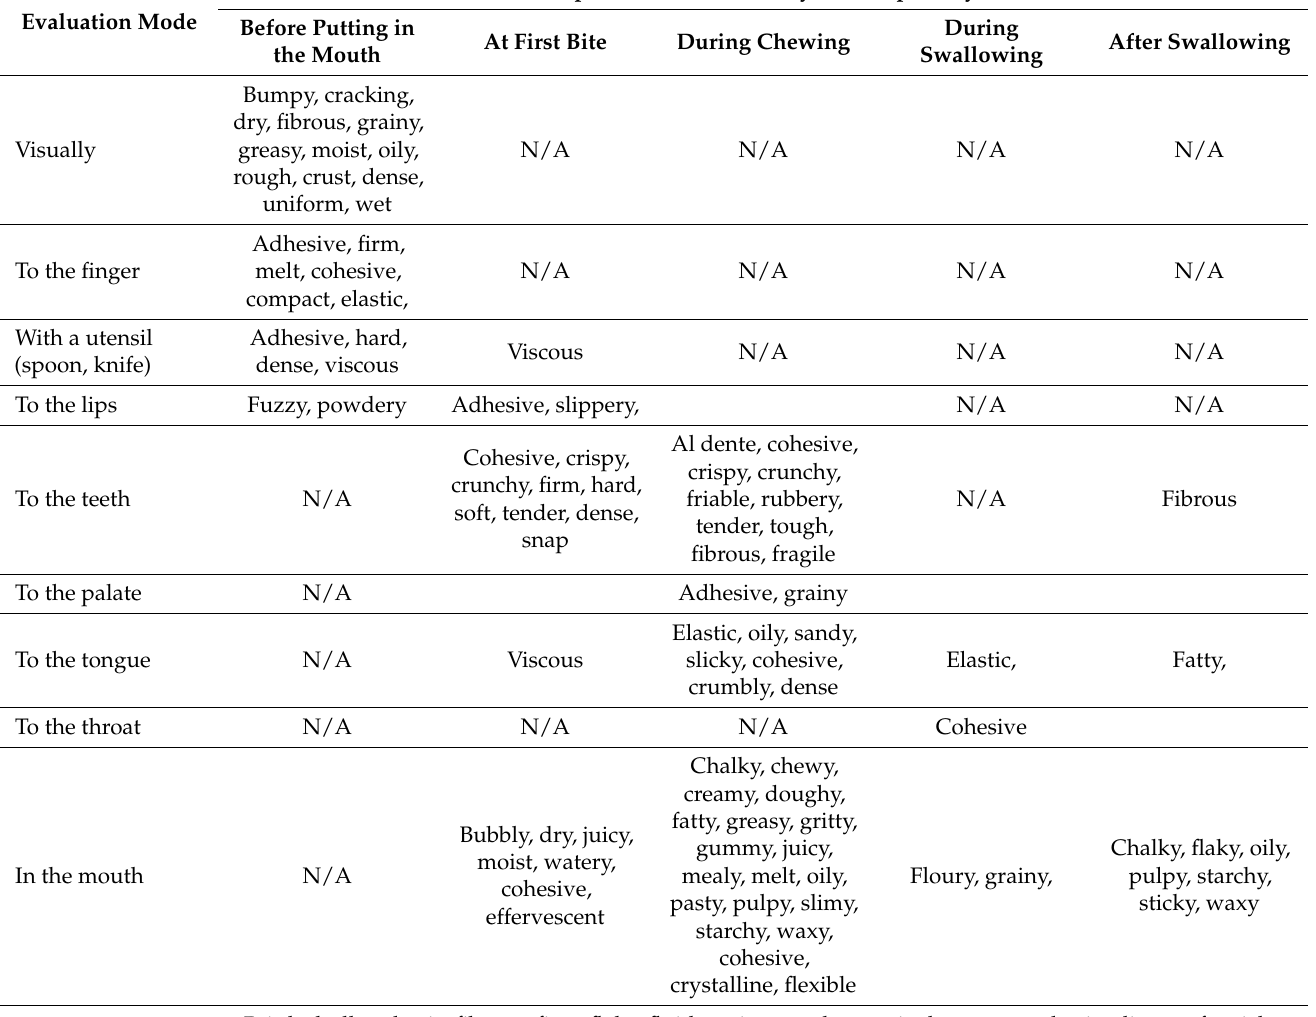
Table 6. Attributes with at least one definition found in lexicons from the literature research and related to temporality and evaluation-mode criteria. N/A indicates that the combination of evaluation mode and temporality is not